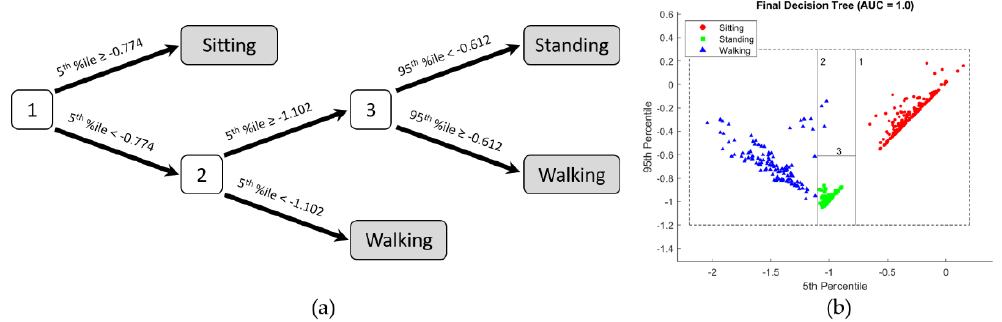
Figure 2. ( a ) Decision tree to classify each minute into Sitting, Standing, and Walking using the 5th and 95th Percentile (%ile) of the accelerometer y -axis (accelerometer attached to the left thigh, y -axis pointing upwards while standing). 99.6% of all minutes were correctly classified using the first two nodes of the decision tree, and 100% using all three nodes. ( b ) The actual measurements, including lines and numbers to visualize the decision tree nodes.